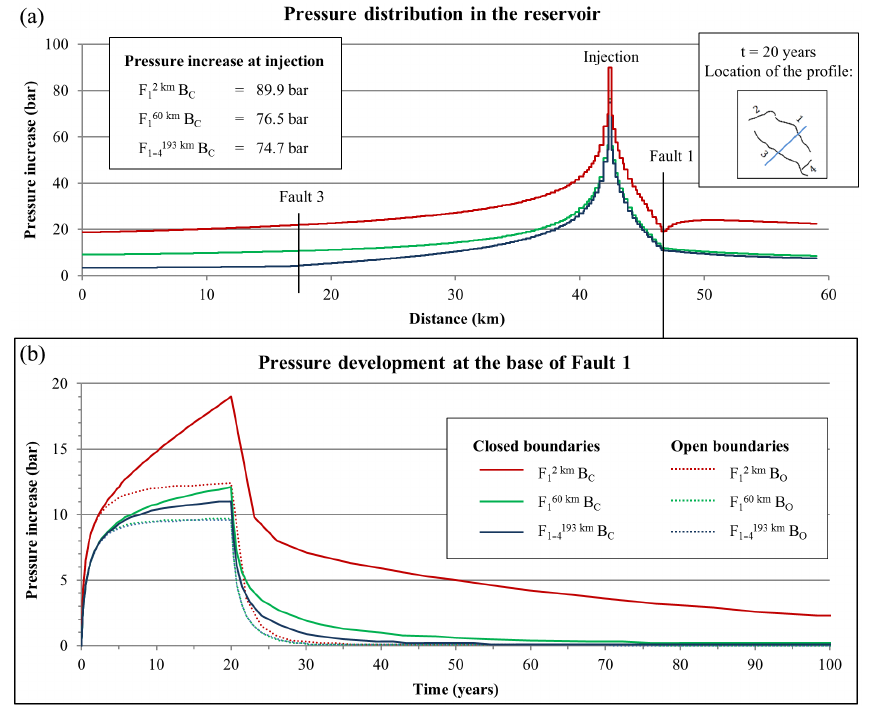
Figure 5. (a) Pressure distribution in the reservoir along the highlighted cross section significantly varies depending on the open fault length. B C ) . (b) Pressure development at the base of Fault 1 indicates a substantially The highest pressurisation is observed for a short fault ( F 2km 1 faster pressure reduction for greater fault lengths.